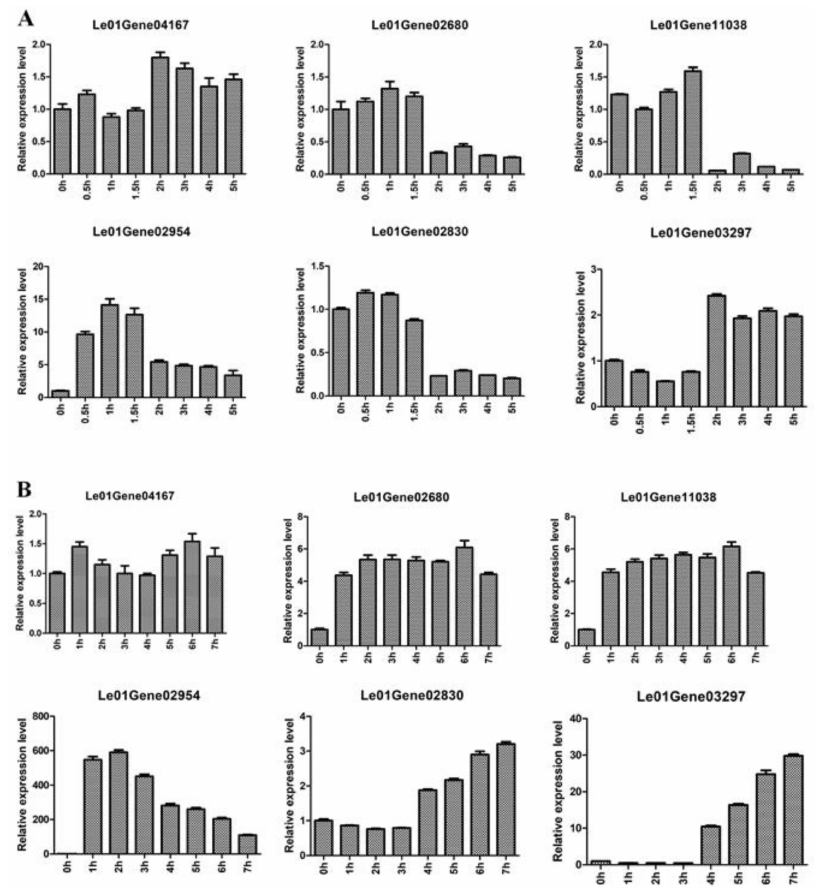
Figure 4. Relative expression of different genes during hot-air drying. Mycelia was treated with 0, 0.5, 1, 1.5, 2, 3, 4, and 5 h ( A ). Fruiting body was treated with 0, 1, 2, 3, 4, 5, 6, and 7 h ( B